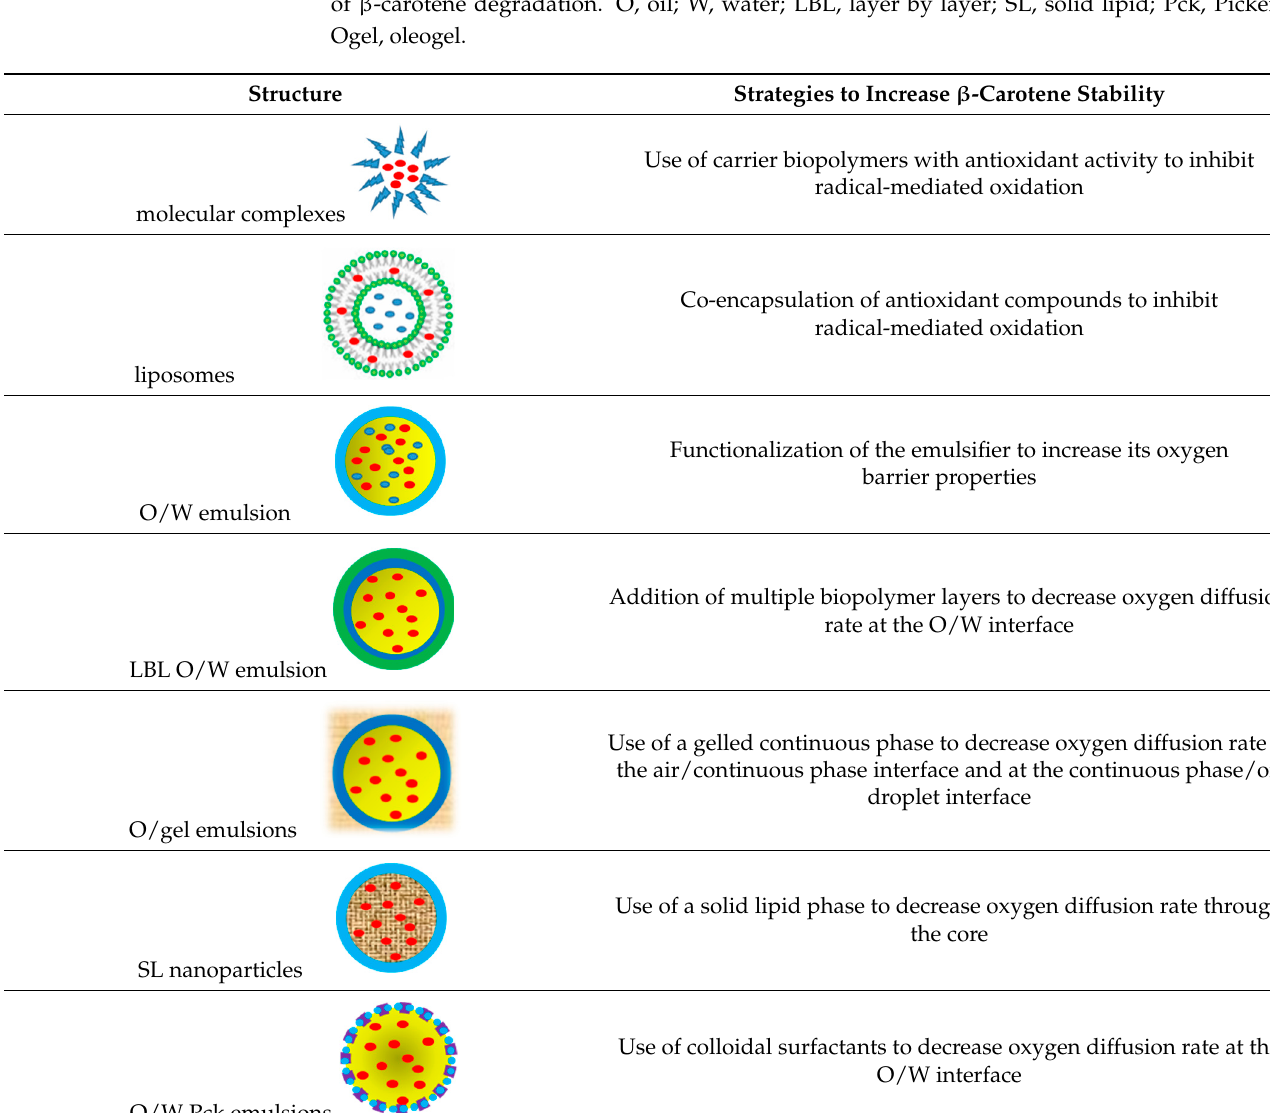
Table 2. Micro- and nano-structures discussed in the text and related strategies to decrease the rate of β -carotene degradation. O, oil; W, water; LBL, layer by layer; SL, solid lipid; Pck, Pickering; Ogel, oleogel.